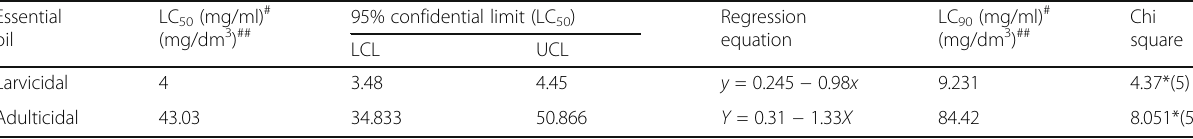
Table 1 Larvicidal and adulticidal activities of bay essential oil on M. domestica Essential oil